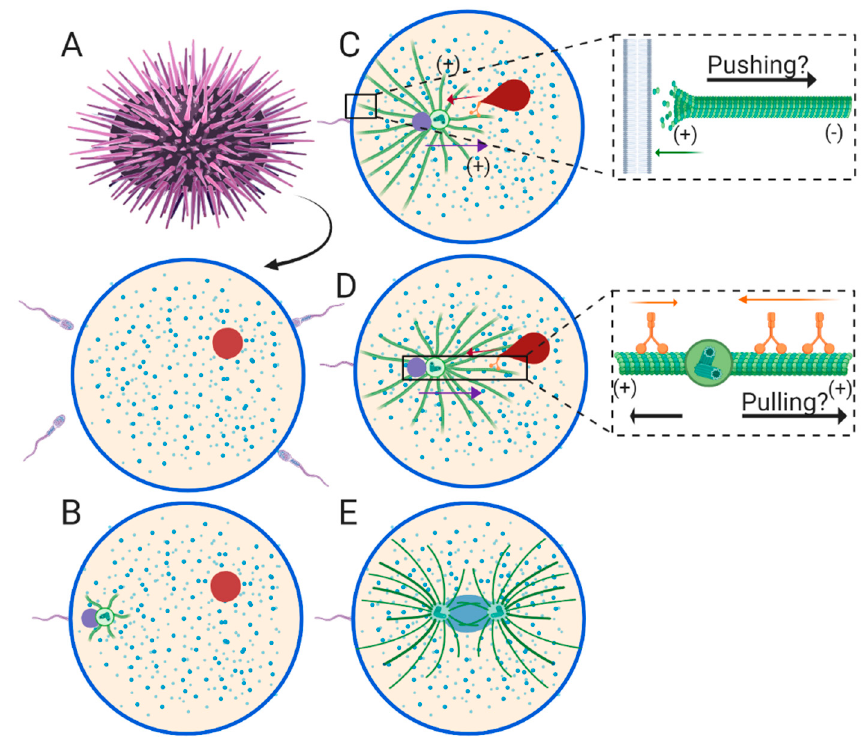
Figure 2. Fertilization and pronuclear migration in the sea urchin (echinoderm). ( A ) The sea urchin oocyte has already completed meiosis resulting in formation of the female pronucleus (red circle), which is located randomly within the oocyte cytoplasm. Fertilization may also occur anywhere around the oocyte. ( B ) Almost immediately after fertilization, the paternally-derived centrosome is attached to the male pronucleus (purple circle) and begins forming the interphase sperm aster near the cortex. During this early time-point the sperm aster does not begin to migrate until astral MTs reach the rear cortex. ( C and D ) As the sperm aster grows, it enters the centration phase where it reaches a constant maximum speed. This velocity is either set by growth rates of rear cortical facing MTs pushing against the cortex as in ( C ), cytoplasmic dynein-dependent pulling forces that scale with MT lengths as in ( D ), or a combination of the two. The female pronucleus is captured by astral MTs and is presumably transported towards the aster center / male pronucleus by dynein. Transport causes the female pronucleus to form a “tear drop” shape ( E ) The sperm aster slows down as it approaches the egg center, prophase centrosomes separation occurs, and pronuclei fuse forming the zygote nucleus (blue oval).